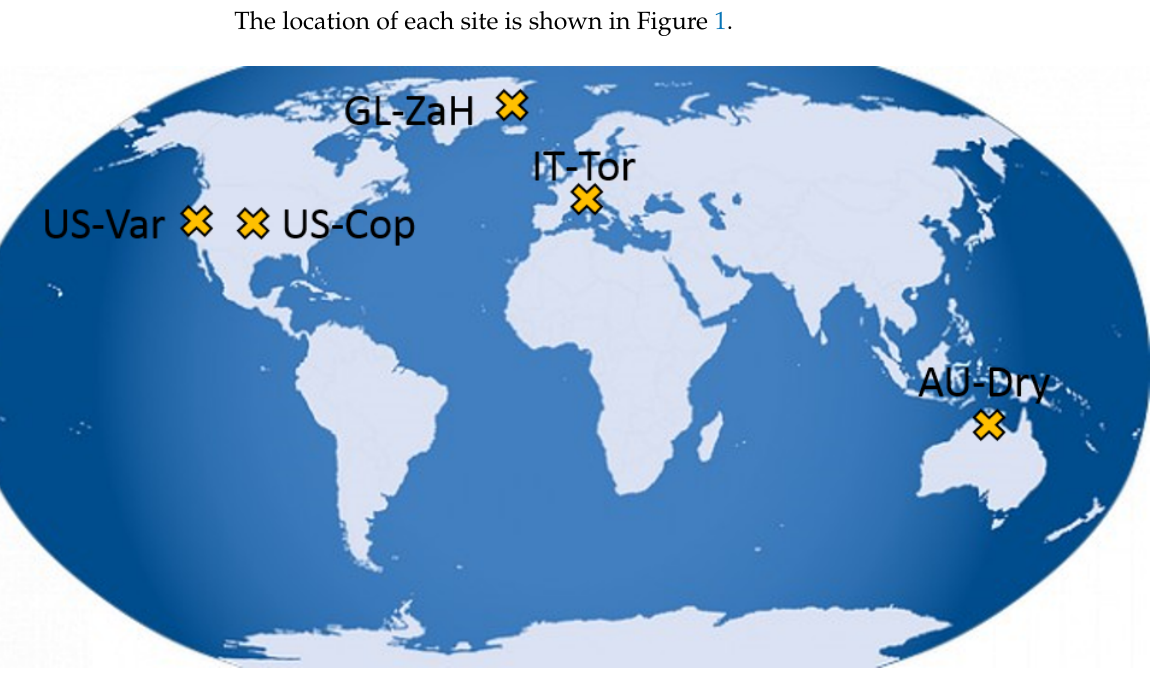
Figure 1. Location of the five eddy covariance